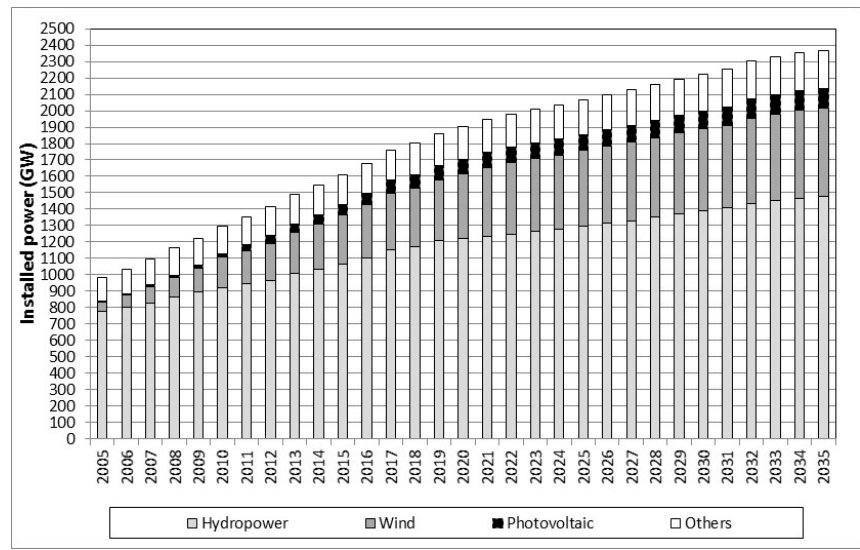
Figure 2. Trends for worldwide renewable energy (adapted from [13]).